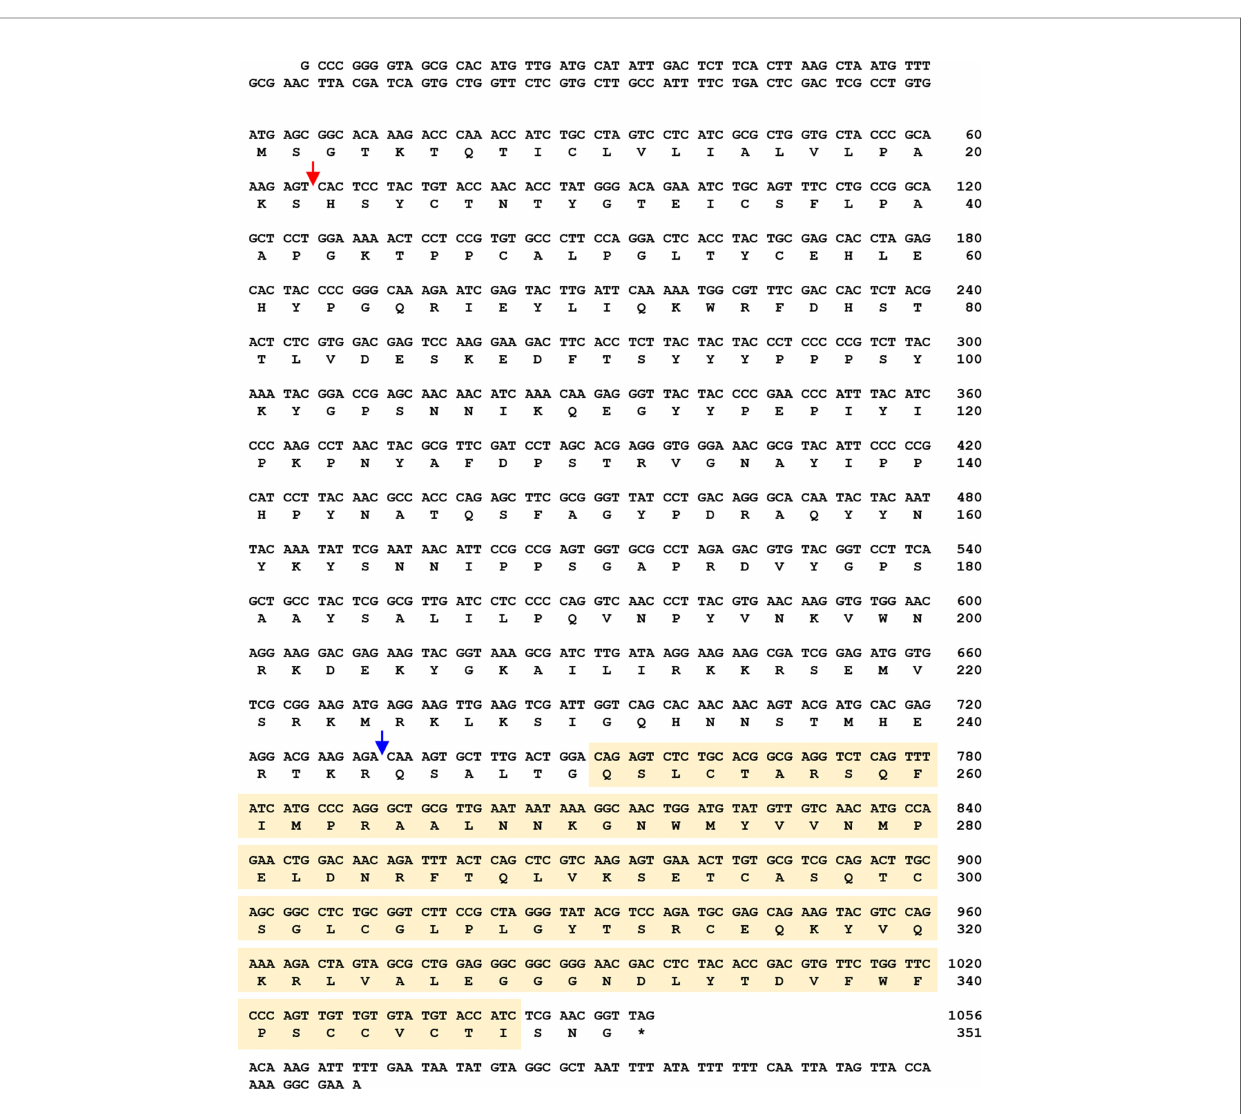
FIGURE 1 | Nucleotide and deduced amino acid sequences of T. molitor Spätzle5 ( TmSpz5 ). The Tm Spz5 full-length open reading frame (ORF) consisted of 1,062 bp, encoding a polypeptide of 353 amino acid residues. The cystine-knot domain is shown in a yellow box, and the signal peptide region and cleavage site are indicated by red and blue arrows, respectively. The stop codon is shown with an